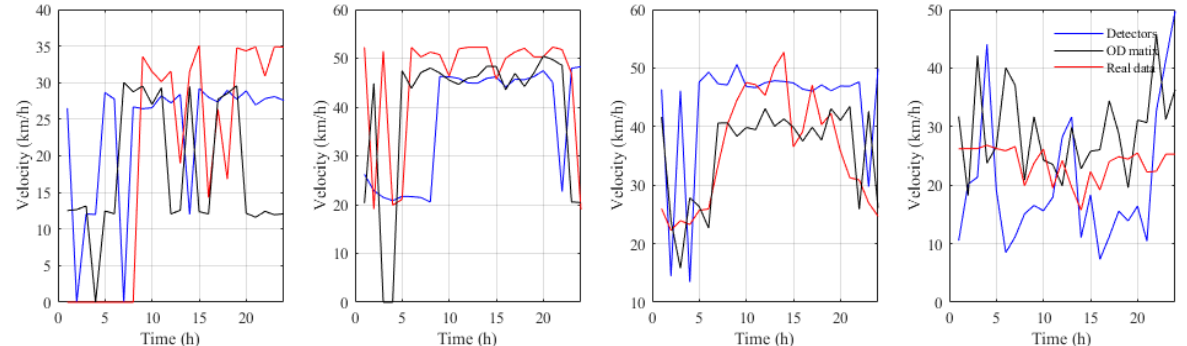
Figure 6. Average velocity of different hours in the verification points. (Red lines, real data; blue lines: simulation of intersection loops data; black lines: simulation of OD matrix data).